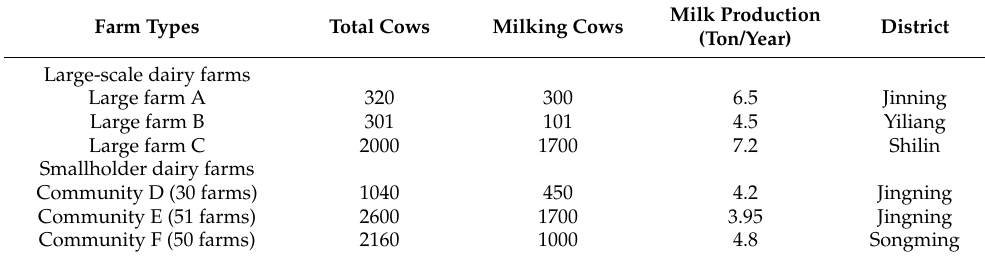
Table 1. Basic information of selected farms to be investigated in the